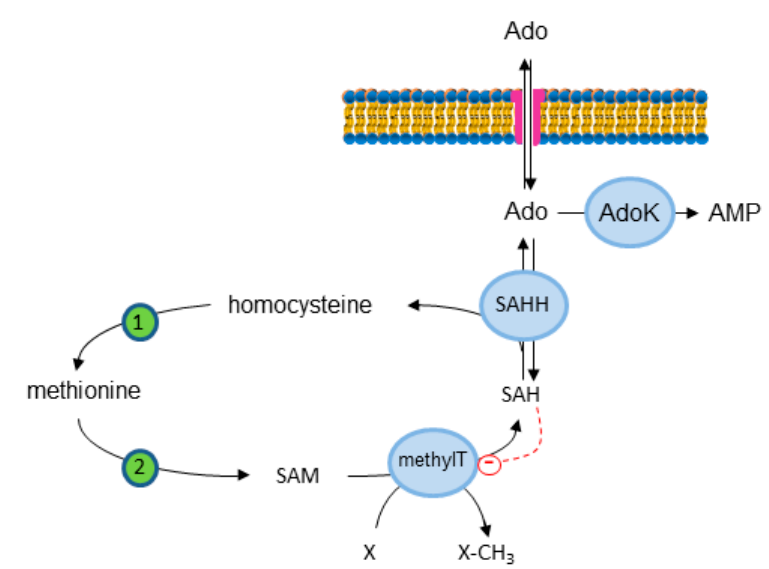
Figure 2. Transmethylation pathway. S -Adenosylhomocysteine (SAH) is hydrolyzed to homocysteine and Ado by S -adenosylhomocysteine hydrolase (SAHH). 1: Methionine synthase. 2: Methionine adenosyl transferase catalyzes the formation of S -adenosylmethionine (SAM). SAM is the donor of methyl group in the transmethylation reactions catalyzed by methyltransferases (MethylT). X: acceptor (protein, DNA, RNA) of the methyl group. SAH is an inhibitor of MethylT (dashed line). Ado can exit or enter the cell through the ENT.